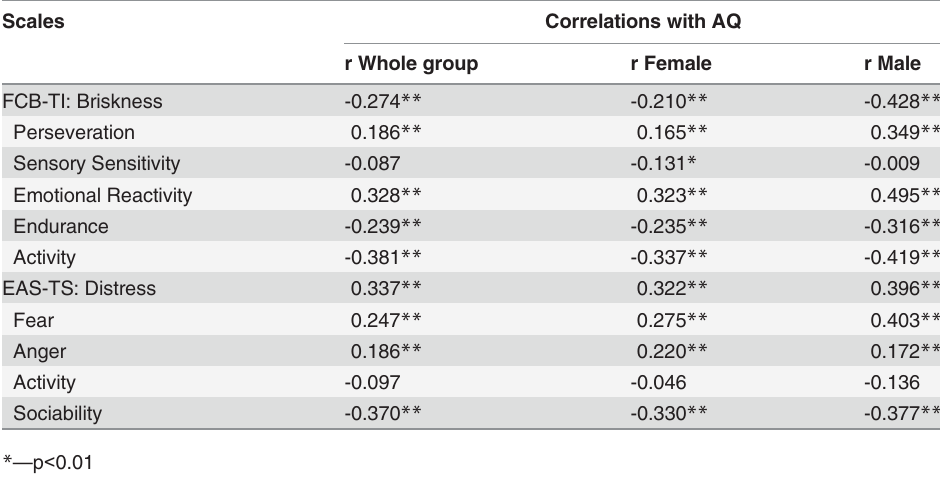
Table 2. Correlations between AQ and FCB-TI and